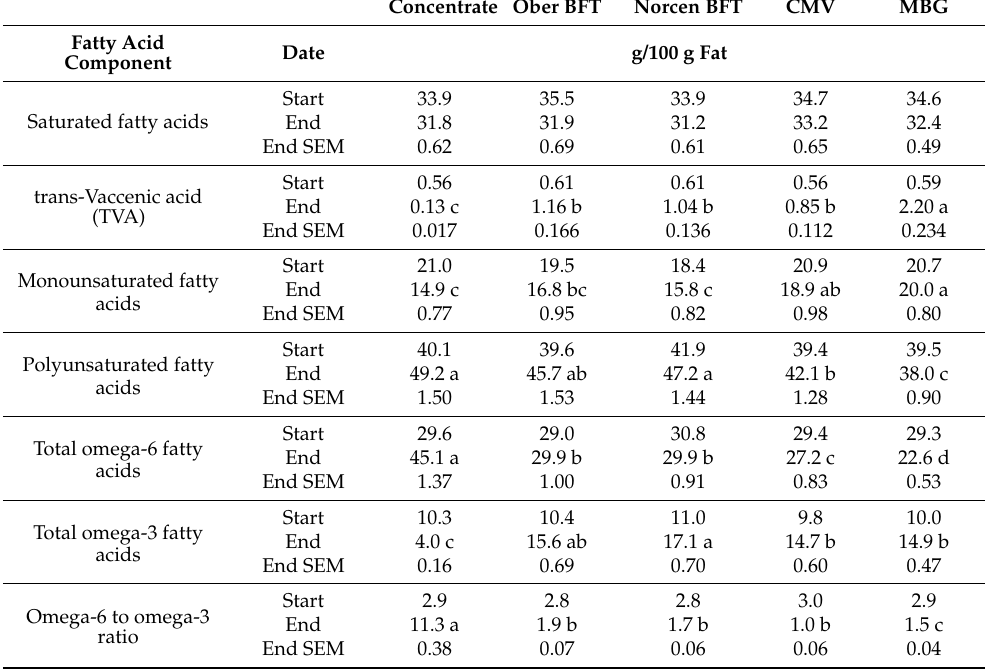
Table 7. LSMEANS of 2013 cattle blood plasma fatty acid composition at the beginning (31 May) and end (23 August) of an 84-day feeding period on a concentrate diet or on perennial legume and grass